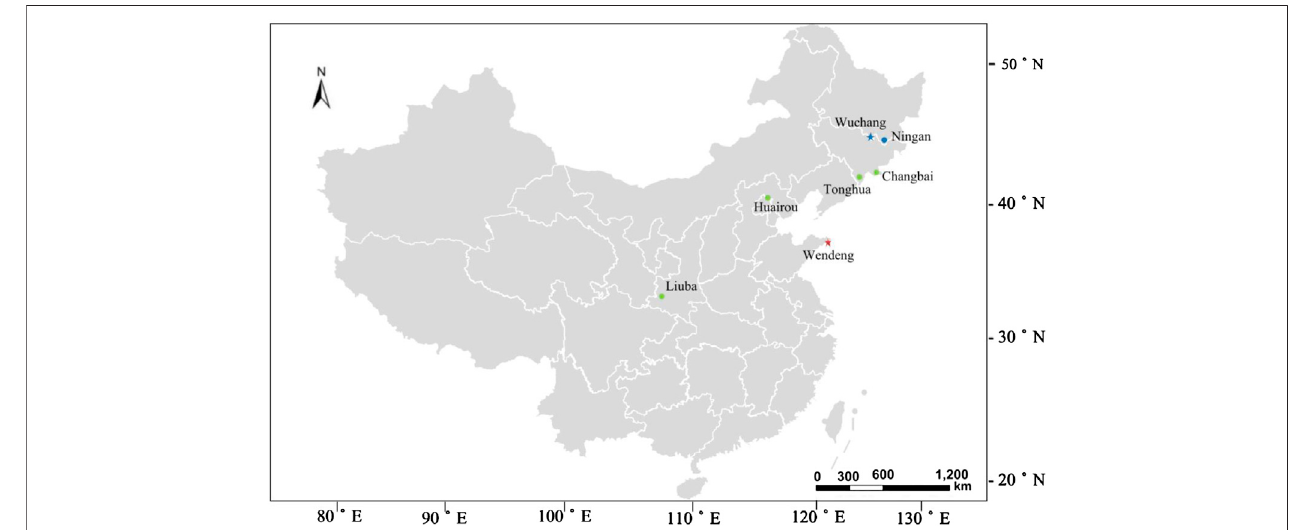
FIGURE 1 | Geographical distribution map of seven American ginseng cultivated locations in